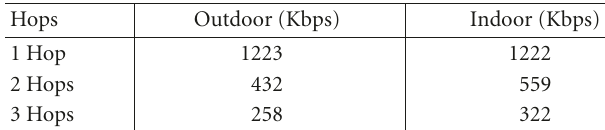
Table 7: Unicast routing and autoconfiguration: indoor and out- door throughputs.